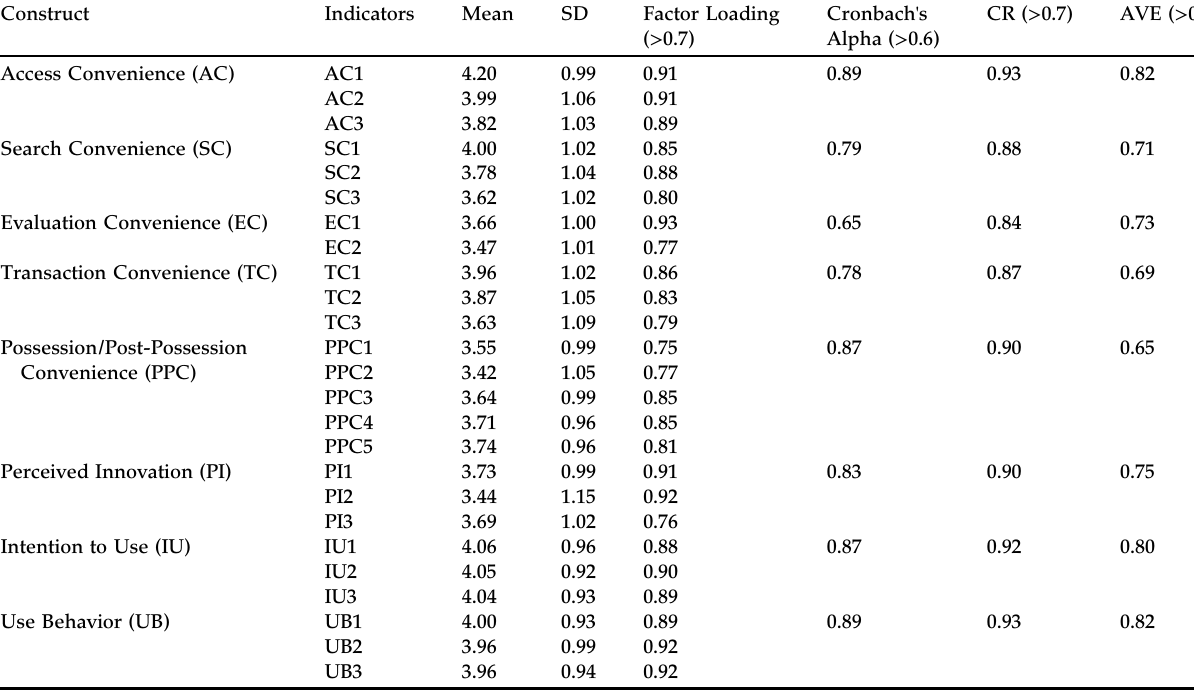
Table 2. Assessment of measurement